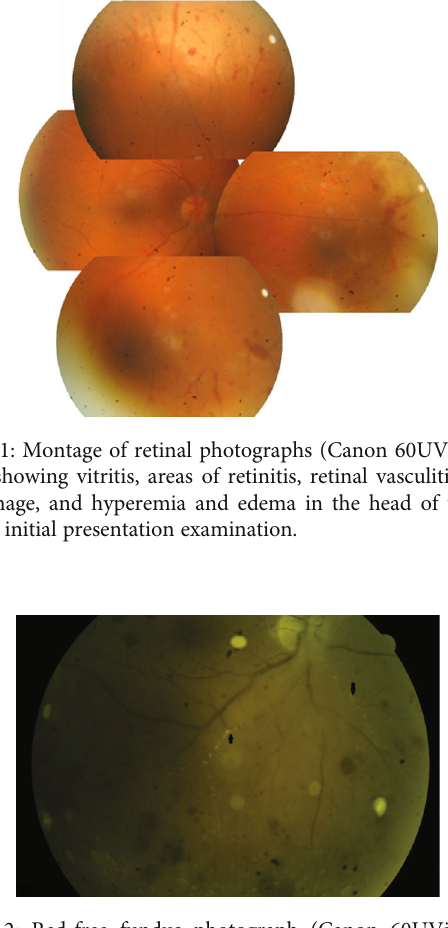
Figure 2: Red-free fundus photograph (Canon 60UVi, Tokyo, Japan) showing occlusive vasculopathy (black